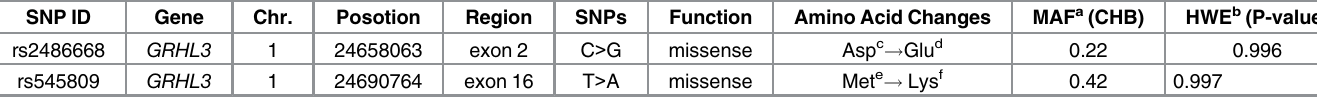
Table 1. General information for genotyped